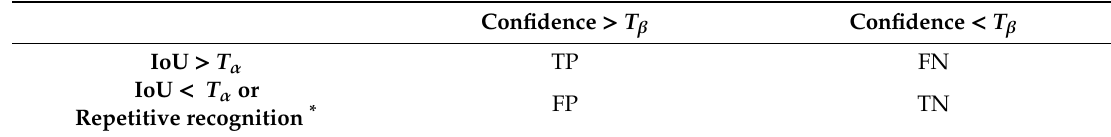
Table 1. The definition of true positive (TP), false positive (FP), true negative (TN), and false negative (FN)